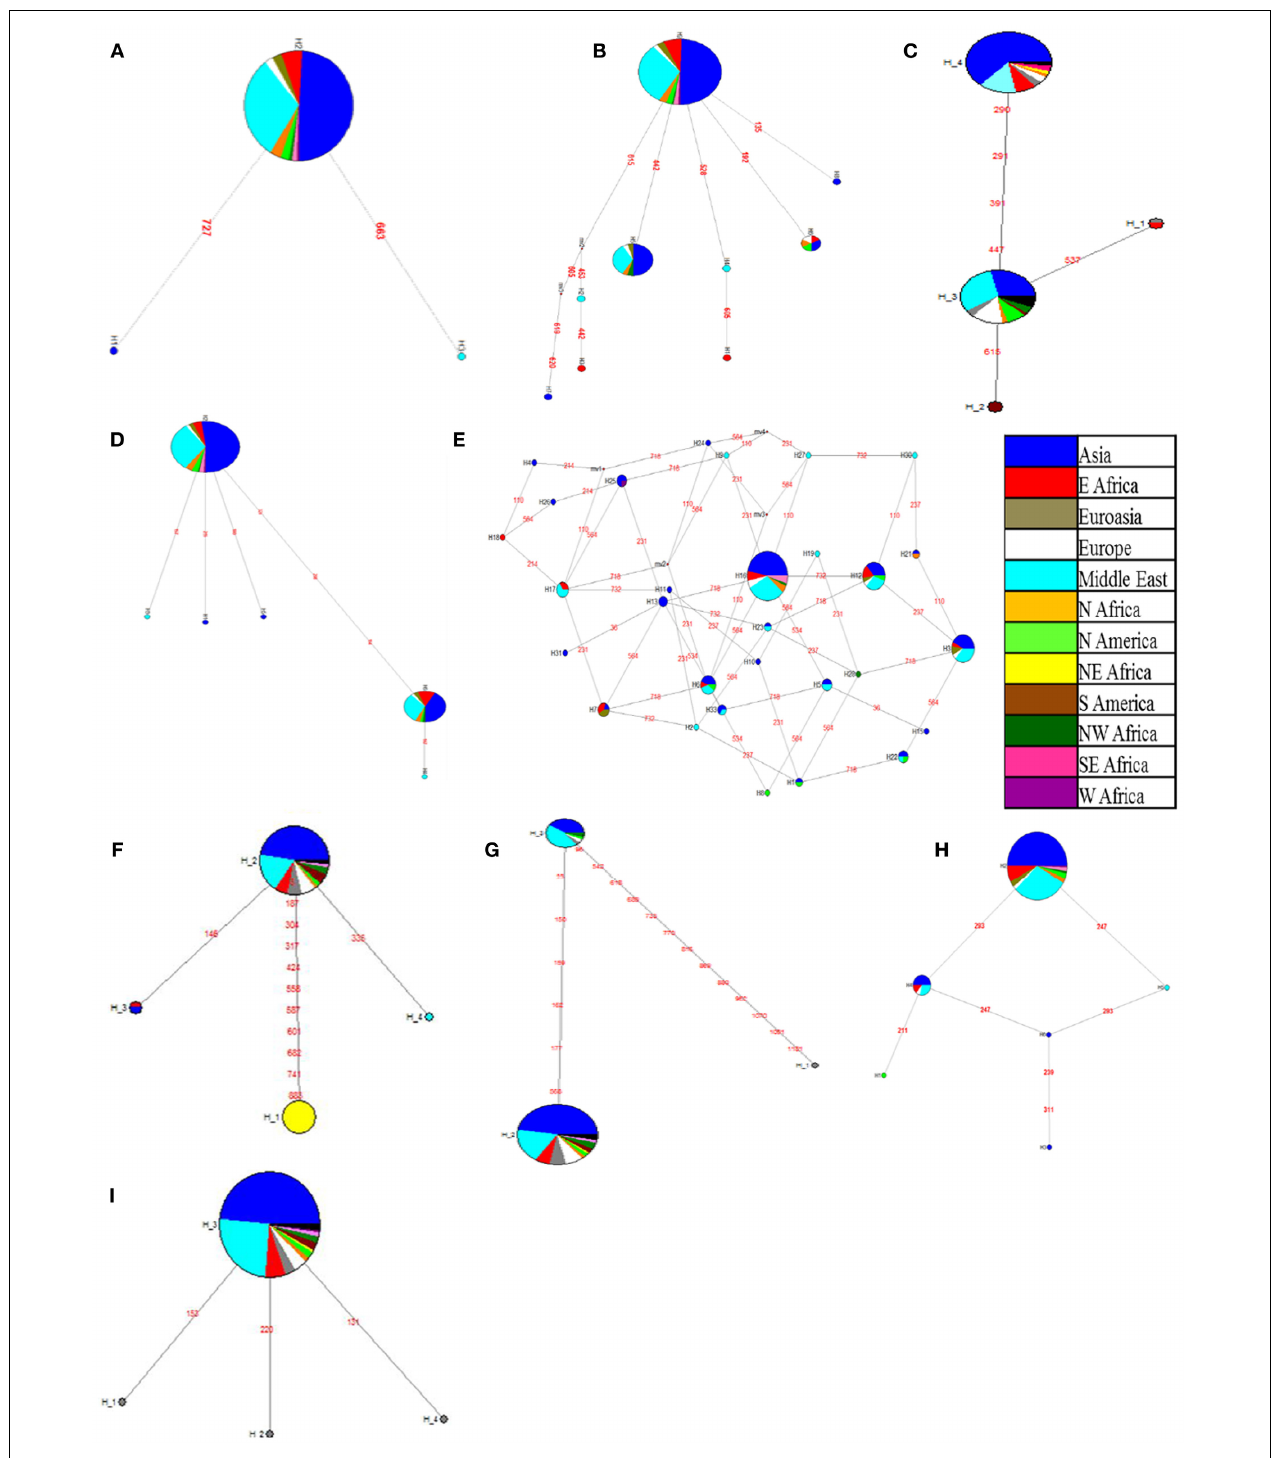
FIGURE 2 | Haplotype network of candidate genes developed based on countryoforiginofgenotypesofthechickpeareferenceset.(A) AKIN gene; (B) AMADH gene; (C) ASR gene; (D) DHN gene; (E) DREB1 gene; (F) ERECTA ( 7f-5r ) gene; (G) ERECTA ( 8f-8r ) gene; (H) MYB gene; (I) SPS gene; Each circle